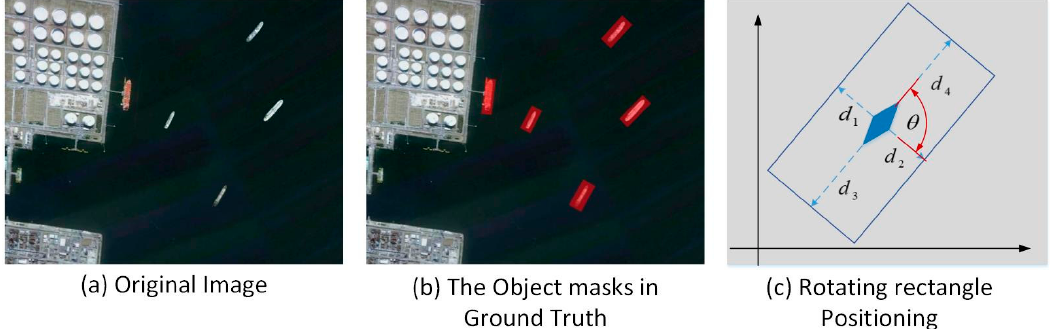
Figure 4. Location of object mask and rotating rectangular frame. ( a ) Original image, ( b ) Object mask generated according to the true coordinates, ( c ) positioning sketch of the rotating rectangular frame.